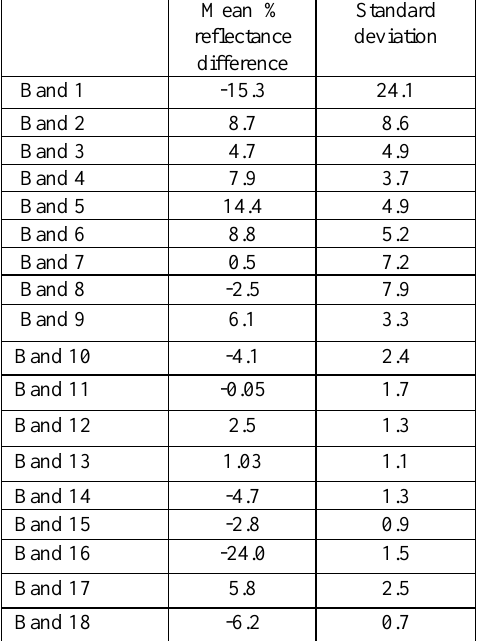
Table 3. Mean and standard deviation of the relative differences of reflectance, for all instrumental channels, obtained with AERONET model with respect to those obtained with the tool BEAM, for the CHRIS image over Bruxelles.